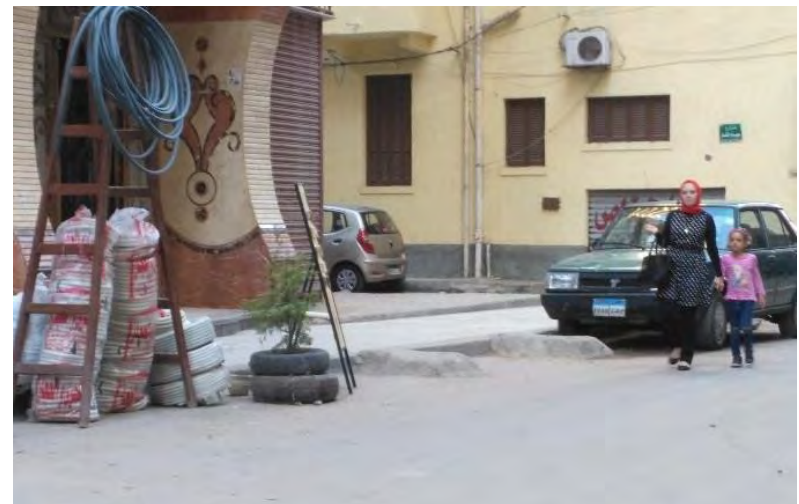
Figure 5. Obstacles in streets and sidewalks create a hostile sense to whom made such obstacles. (The researcher,